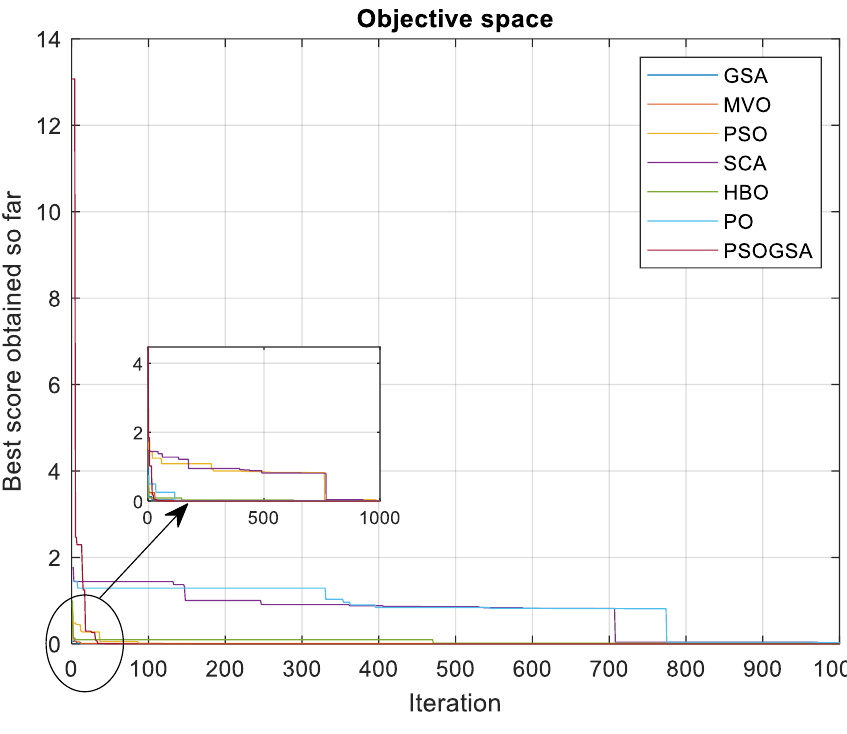
Figure 11. The convergence curve of the polycrystalline MSDM. Table 13. The MSDM calculation error, mean, standard deviation for the polycrystalline PV Cell .